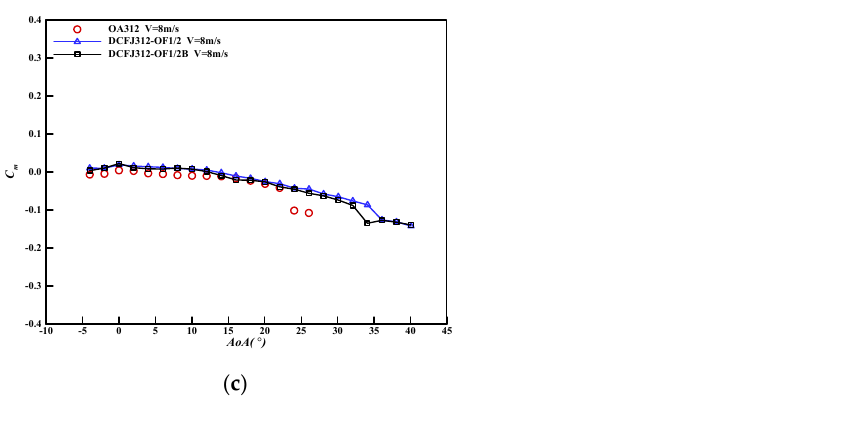
Figure 14. Aerodynamic coefficients comparisons of DCFJ312 airfoils with various RUL s. ( a ) Lift coefficient; ( b ) lift-to-drag ratio; ( c ) moment coefficient. Table 11. Comparisons of maximum lift coefficients and stall AoA s of DCFJ312 airfoils with various RUL s.